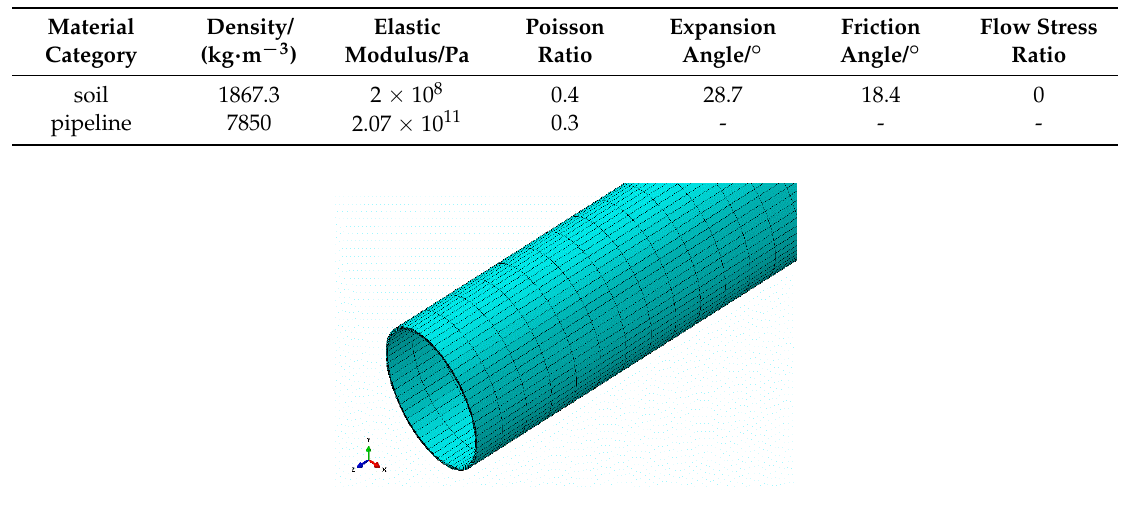
Table 6. Basic parameters of the material.